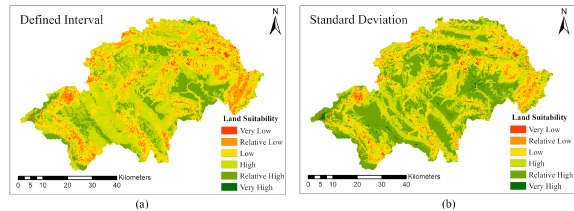
Figure 3. The 6-class land suitability maps of Shennongjia Forest District using (a) Defined interval, (b) Standard